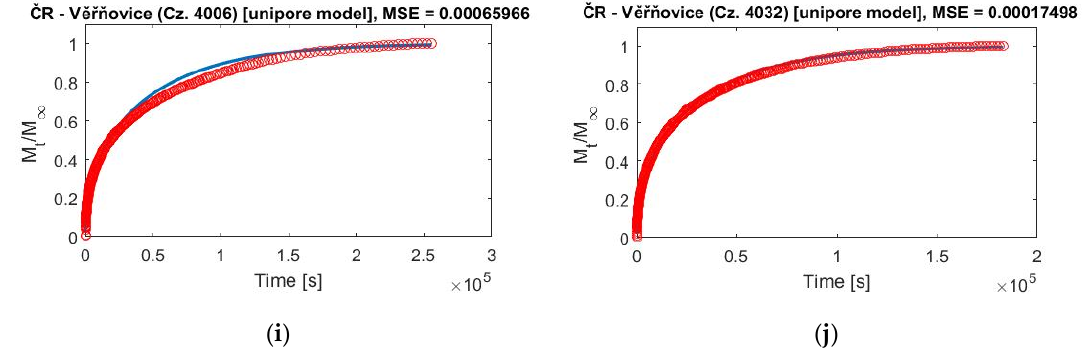
Figure 4. Fitting of the unipore model runs with experimental sorption data: ( a ) Sobieski (D-25); ( b ) Sobieski (D-24); ( c ) Piast (D-34); ( d ) Mys ł owice-Weso ł a (D-37); ( e ) Borynia (D-6); ( f ) Zofiówka (D-22); ( g ) Pniówek (D-7); ( h ) Zofiówka (D-23); ( i ) Č R-V ěřň ovice (Cz. 4006); ( j ) Č R-V ěřň ovice (Cz. 4032).